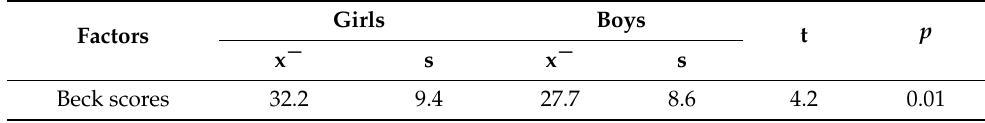
Table 2. Severity of depression on the Beck scale.